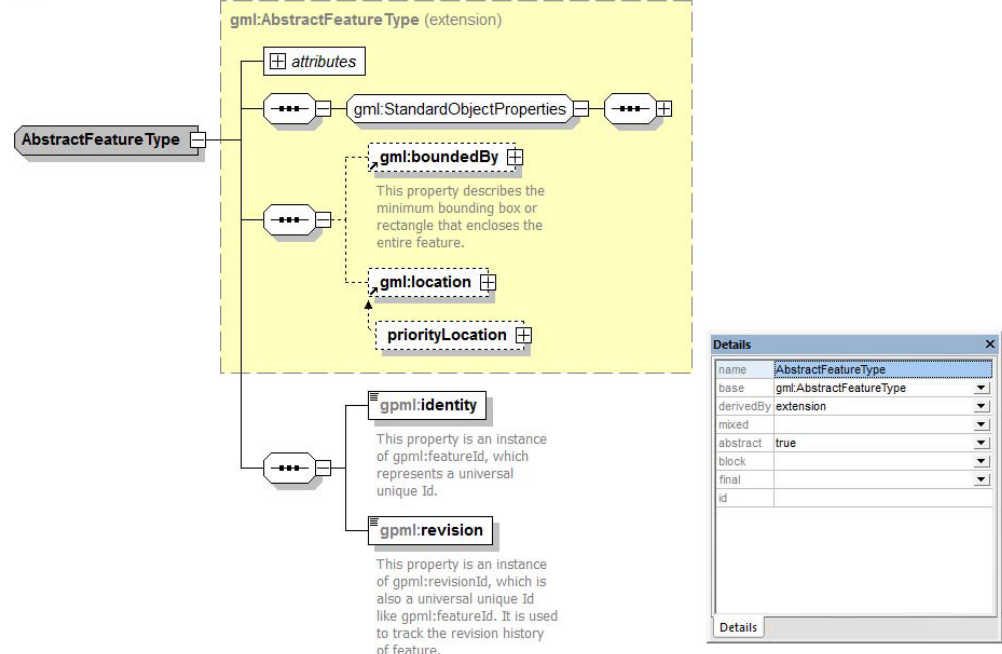
Fig. 8. The AbstractFeature schema diagram in